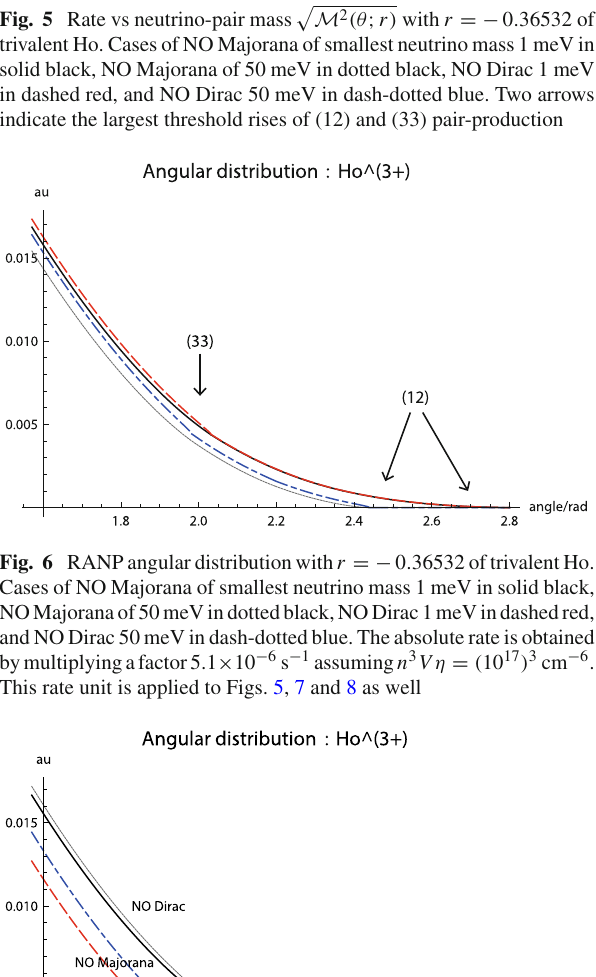
and IO Dirac 5 meV in dash-dotted